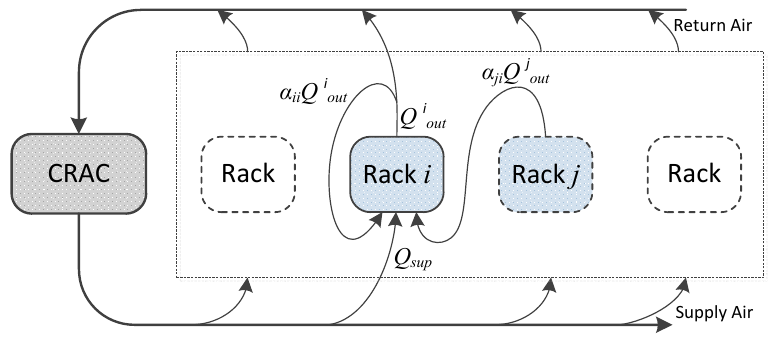
Figure 2. Schematic of thermal cross-interference in data center.